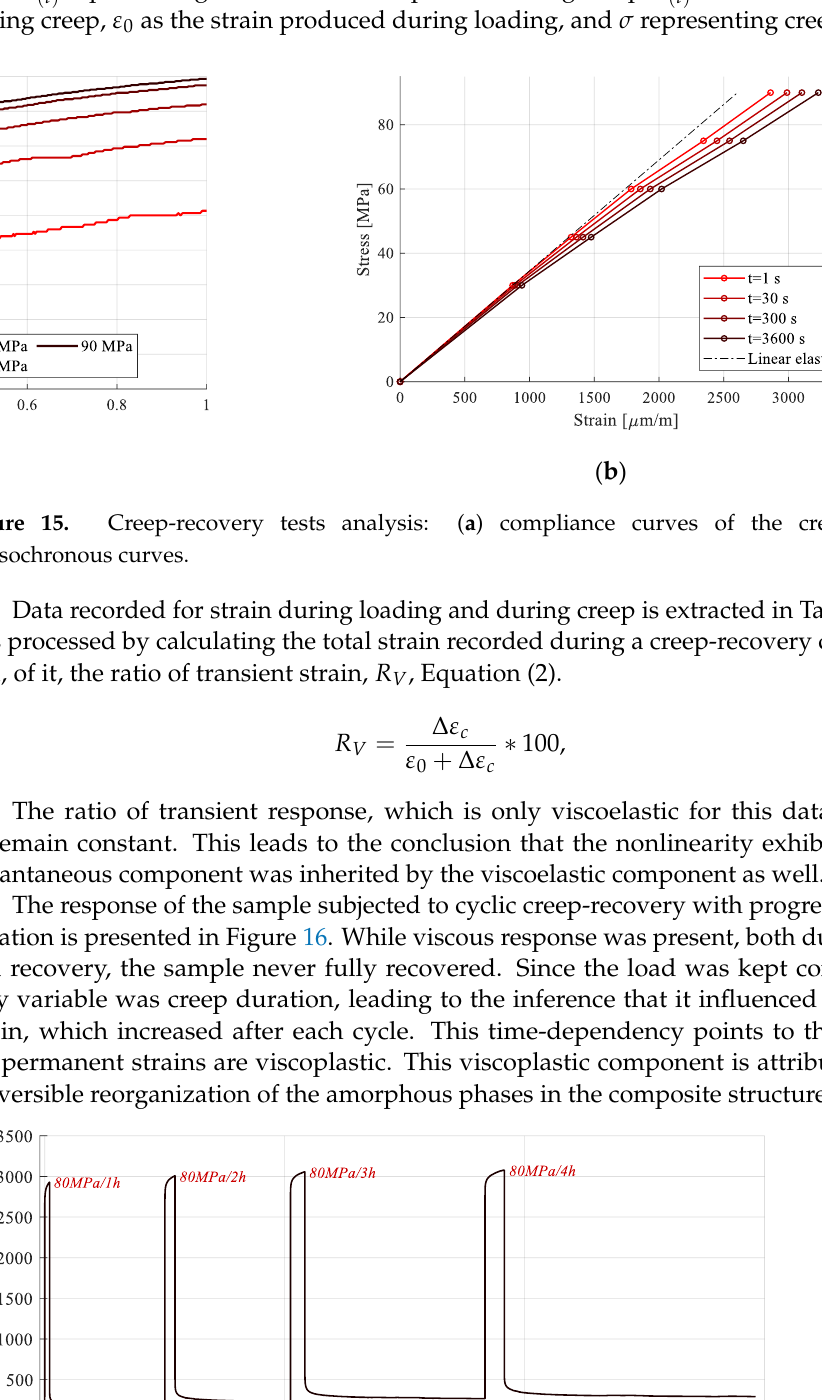
Figure 14. Loading phases of the creep-recovery cycles: ( a ) loading; ( b ) creep; ( c ) recovery.